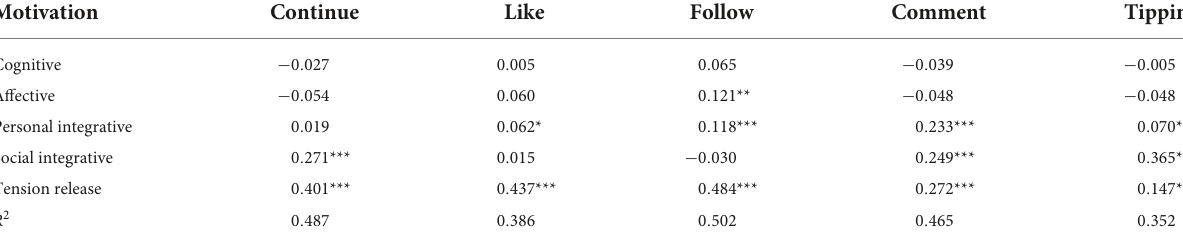
TABLE 4 Direct effects of gratifications on support